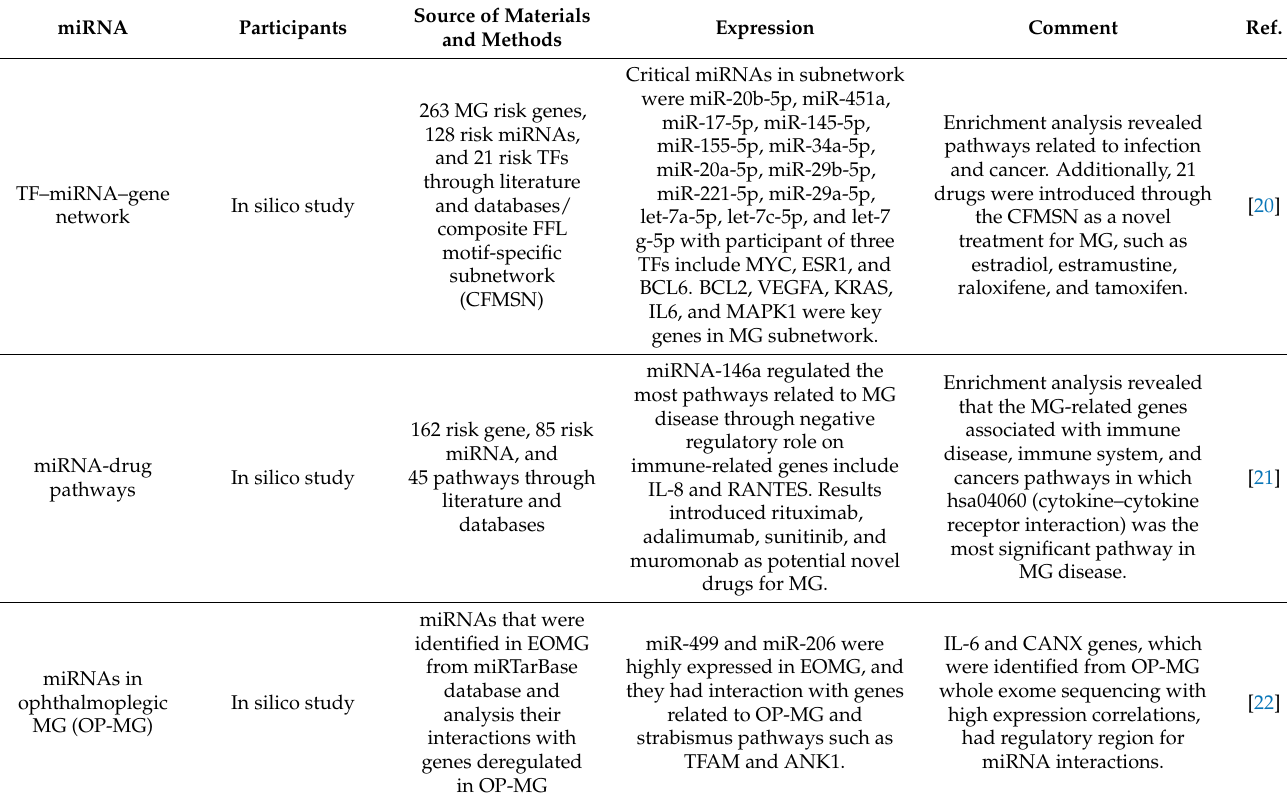
Table 2. Role of miRNAs in MG (PBMC: peripheral blood mononuclear cell, qRT-PCR: quantitative reverse transcription PCR, HC: healthy control, NC: negative control (cardiac surgery cases), LOMG: late-onset myasthenia gravis, EOMG: early-onset myasthenia gravis, TAMG: thymoma-associated myasthenia gravis, MGH: myasthenia gravis patients with thymus hyperplasia, OMG: ocular myasthenia gravis, GMG: generalized myasthenia gravis, RTX: rituximab, QMGS: Quantitative Myasthenia Gravis